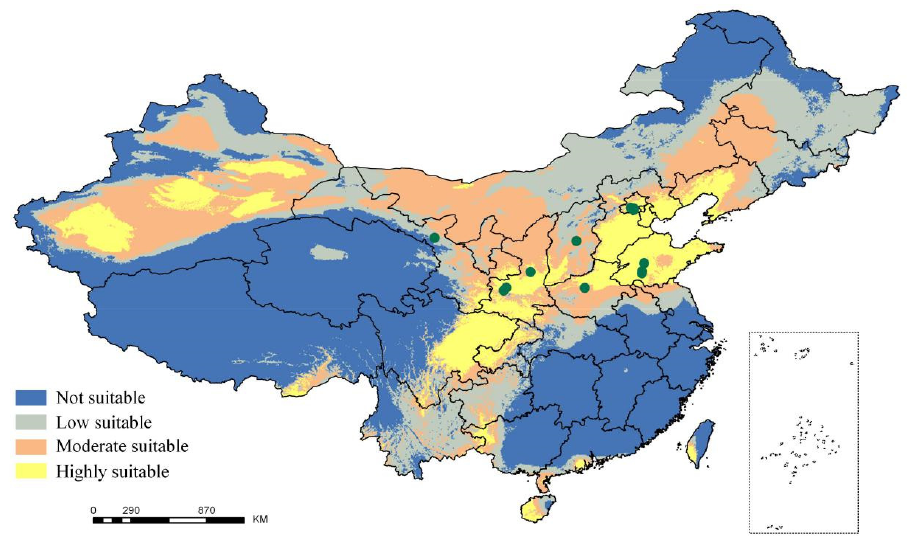
Figure 2. Predicted distribution of suitable regions for ancient P. orientalis populations. The green points represent the location of sample collection sites. points represent the location of sample collection